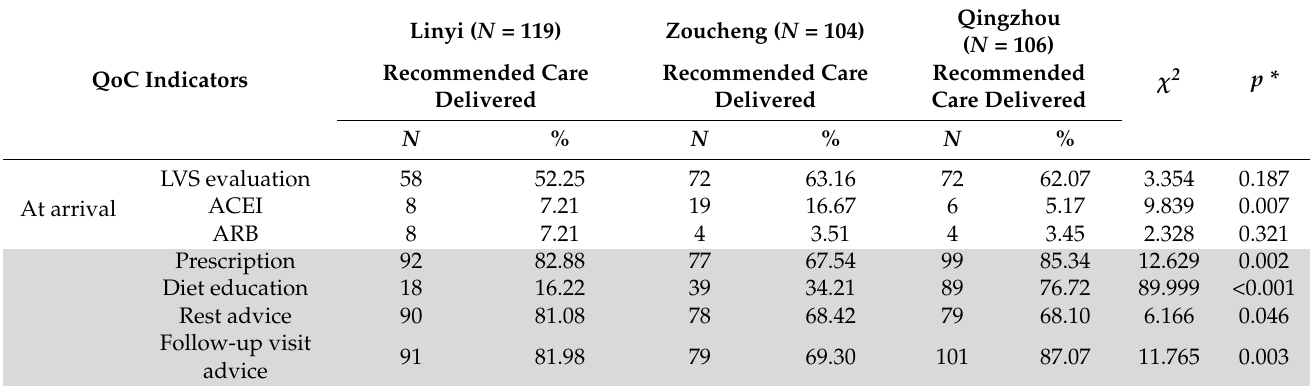
Table 10. Level of QoC for heart failure in 3 selected counties ( N =